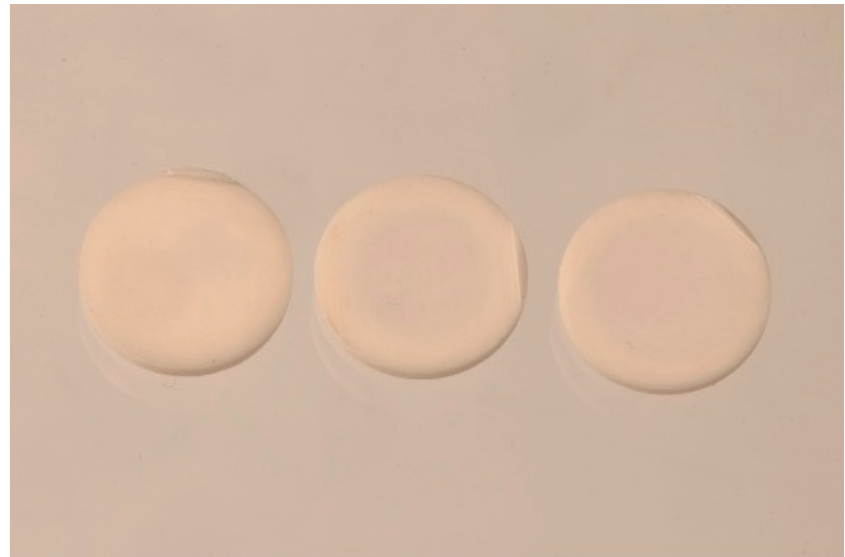
Figure 2. Photo of three specimens being sintered before the specimens are cut to the final thickness. The specimens are of different depth of the finally sintered cylinder of 3Y-TZP with the same diameter and thickness. Different color saturation can be seen from right to left. Table 2. Means (SD) in µ m (Ra) of Surface roughness measured with laser scanning microscopy.